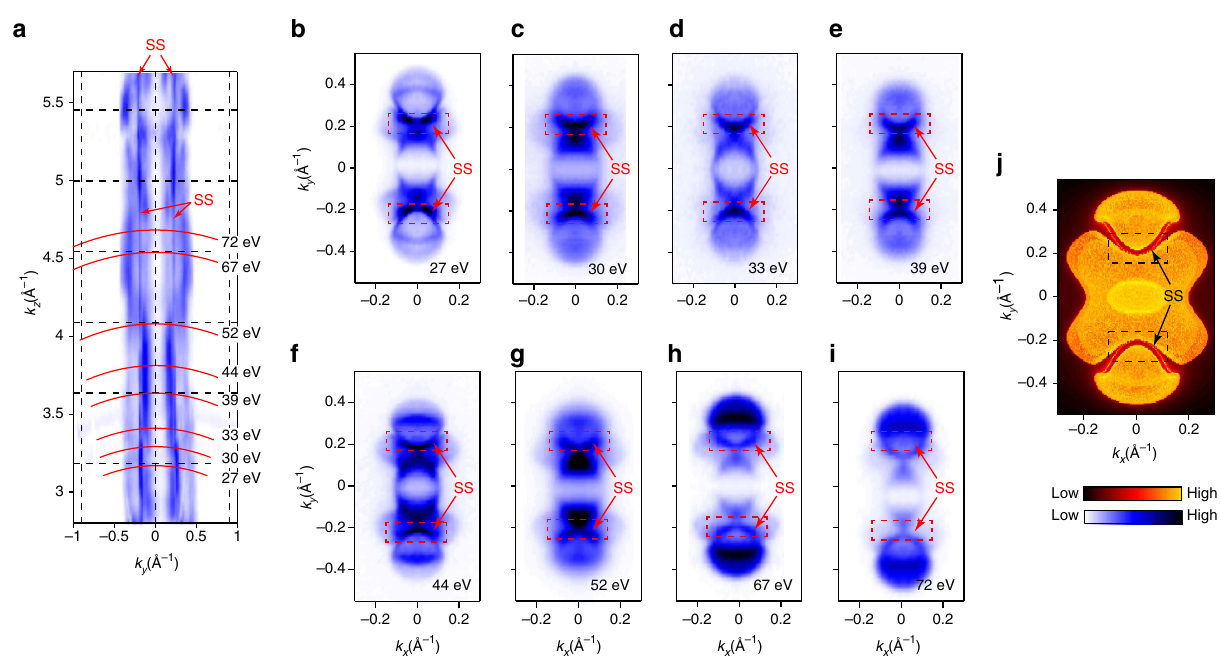
Figure 3 | Bulk and surface electronic states of MoTe 2 probed by photon energy-dependent ARPES measurements. ( a ) The photoemission spectral intensity map in k y – k z plane, where the red arrows indicate the surface states (marked as SS) that show no dispersion along the k z direction. Red curves indicate the k z locations of different photon energies. ( b – i ) Fermi surfaces measured under different photon energies as indicated in a . Red dashed rectangles and arrows highlight the position of the surface states that do not change shape with the photon energies. ( j ) Calculated Fermi surface with black dashed rectangles highlighting the same area as in b – i indicating clear surface states inside.